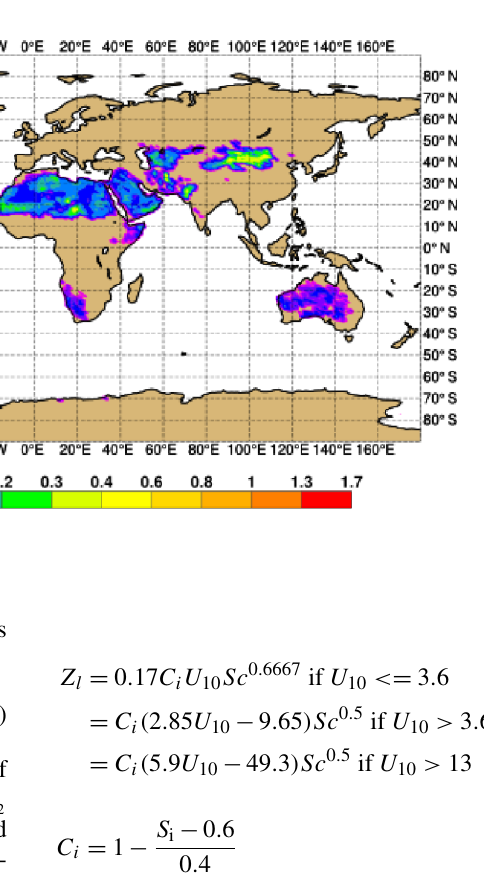
Figure 4. The 2017 lifting threshold speed (ms − 1 ).